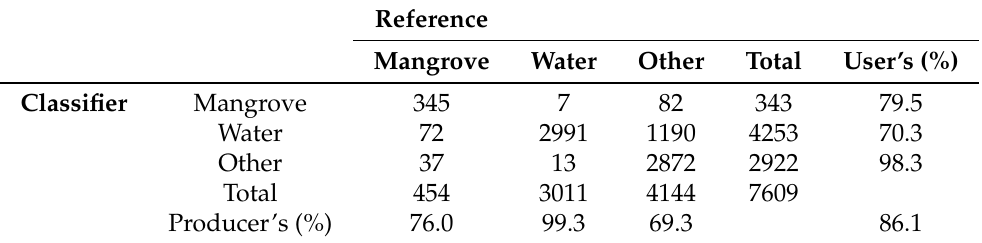
Table 8. Results of spatiotemporal accuracy assessment for the Gulf of Carpentaria, Northern